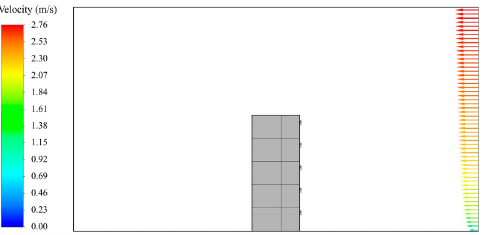
Figure 4. Application of vertical velocity profile using UDF (Section-ABCD).